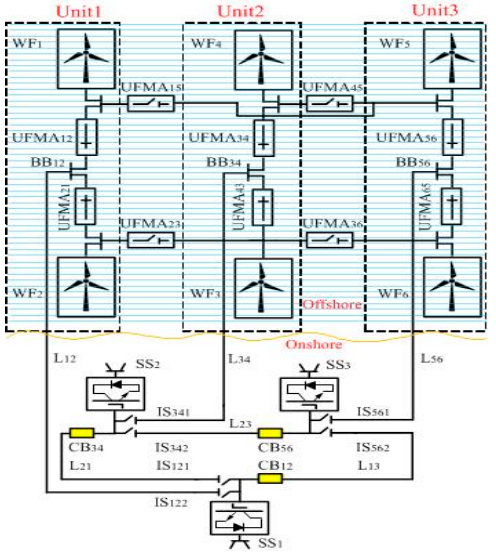
Figure 6. 2WF-SSRT topology.